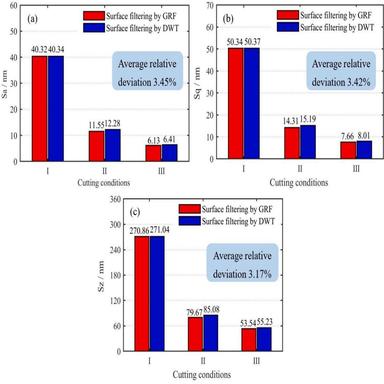
Surface texture parameters of the S–F surfaces filtered by DWT and the GRF at different machining conditions for (a) Sa, (b) Sq, and (c) Sz.